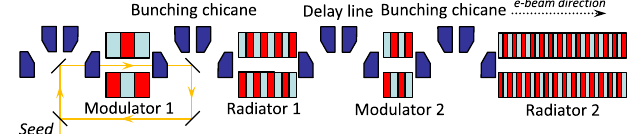
FIG. 4. Layout for the cascaded HGHG setup. The FEL pulse from the 1st HGHG stage on the left is used on an unbunched part of the electron bunch in a second stage. Therefore, the seed pulse needs to be significantly shorter than the electron bunch and a delay line is used to shift the electron bunch with respect to the FEL pulse, applying the so-called fresh-bunch technique. Be- cause both HGHG stages use an up-conversion of the seed wavelength, much shorter wavelength can be reached, typically a factor of 50 or more compared to the original